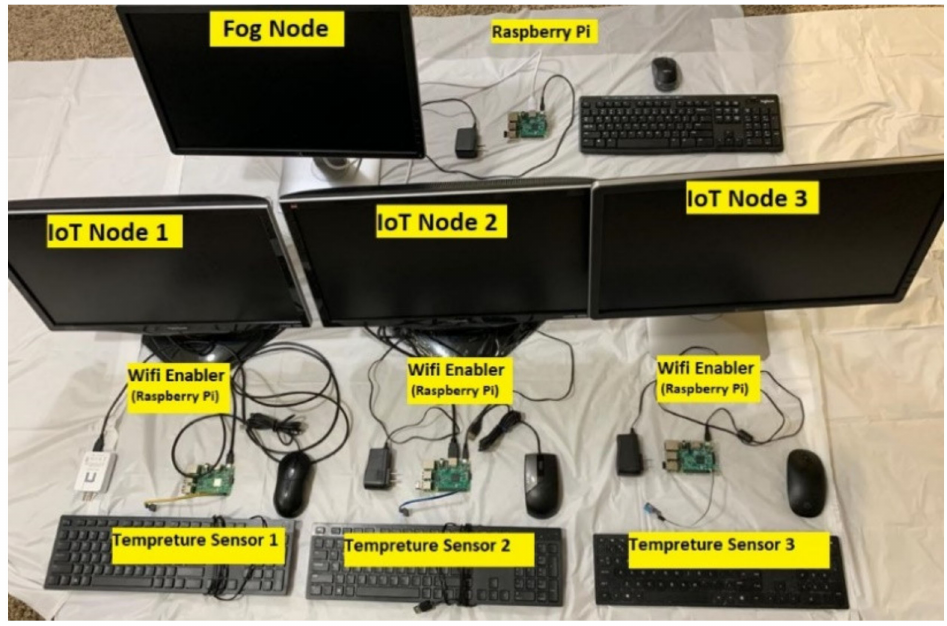
Figure 6. Hardware used in the IoT–Fog–Cloud